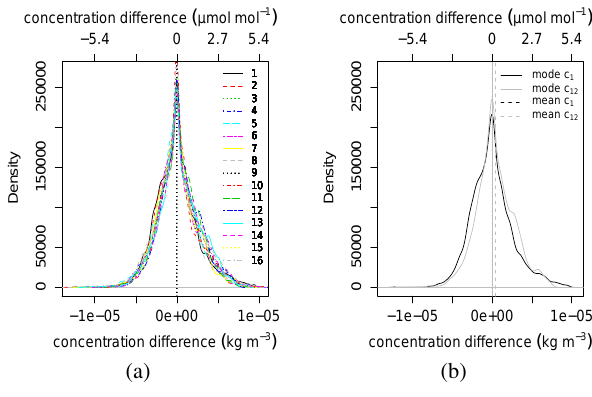
Fig. 5. Density distribution of LES modelled concentration dif- ferences c i (t) − ˜ c(t) of a point measurement c i (t) relative to the field average concentration ˜ c(t) for concentration time series c 1 (t),c 2 (t),...,c 16 (t) and n = 16 sensor locations 1 , 2 ,..., 16 (a) , and for c 1 (t) and c 12 (t) at sensor locations 1 and 12 (b) . Note that the density distributions of c 1 (t) − ˜ c(t) and c 12 (t) − ˜ c(t) have a common mode but different mean.